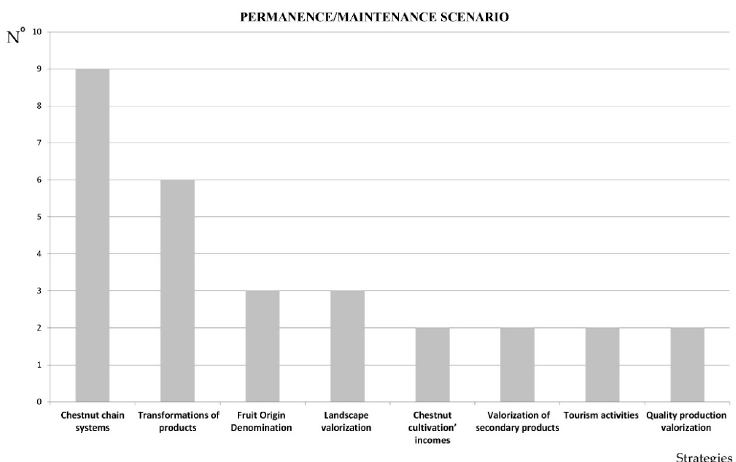
Figure 4. Strategies identified by focus group participants to maintain traditional chestnut cultivation according to the number of preferences received (N°). Almost a third (31%) of focus group participants considered strengthening the chestnut chain system the strategy to conserve the traditional chestnut system, while improved processing of the product, fruit designation of origin, and landscape valorization (21%, 10%, and 10%, respectively) were considered suitable strategies. Quality production valorization (fresh and dried chestnuts), secondary product valorization (honey, mushrooms, wood, and underwood products), touristic activity development, and chestnut cultivation incomes were the other strategies identified by the focus group participants (total equal to 28%). For focus group participants, “valorization” meant the